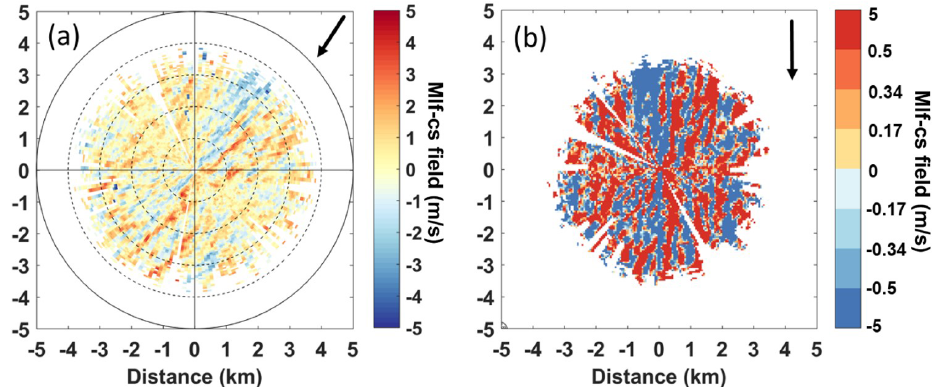
Figure 6. The mlf-cs field (a) before and (b) after image pre-processing with the arrow representing the mean wind direction on 10 September 2014 at 19:57UTC.